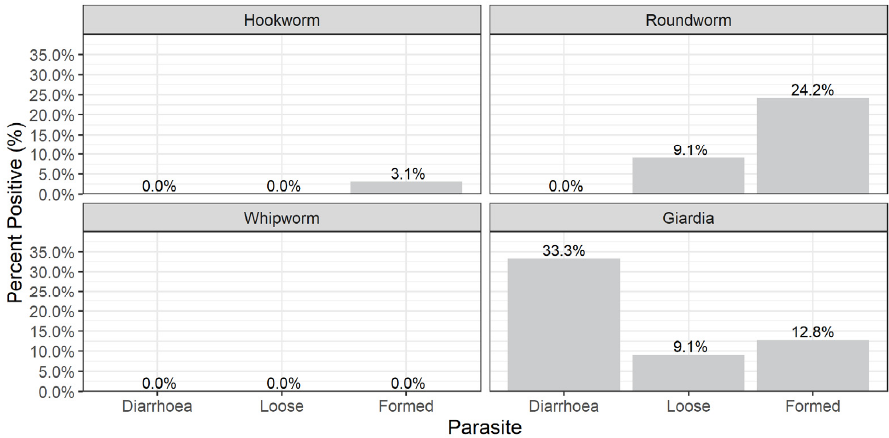
Figure 4. The relationship between faecal consistency and parasites detected in cat samples.